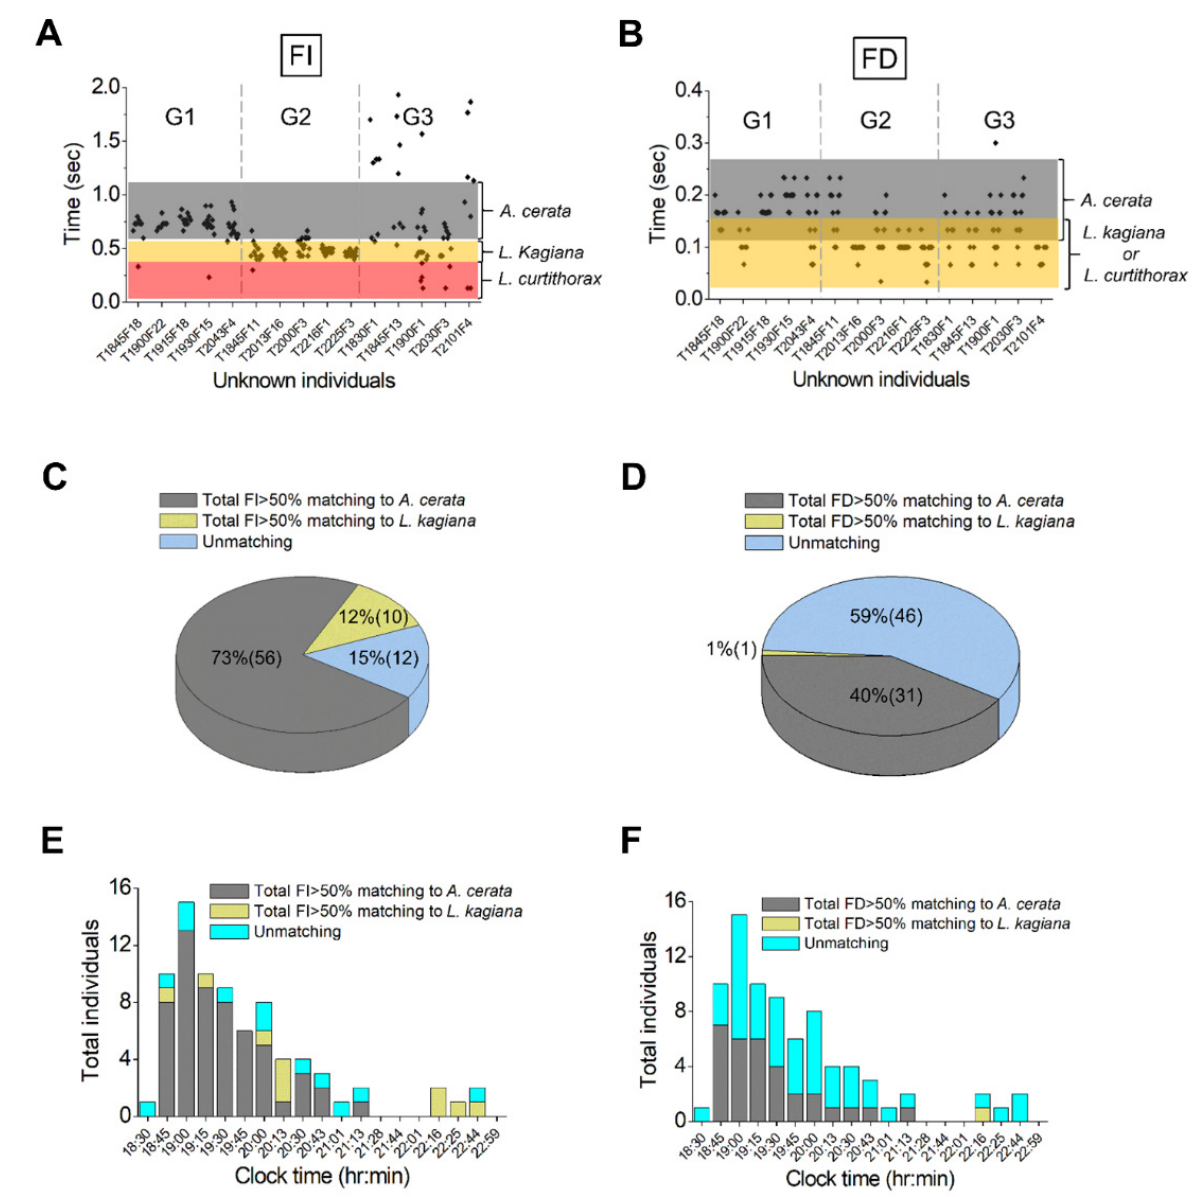
Figure 5. Determining the species composition and active time of the flying population in the case study using FI and FD pattern matching. For the case study on 21 April 2018, flying individuals can be divided into three distinct groups (G1, G2, and G3) according to their FI patterns. ( A ) FI and ( B ) FD patterns of 15 individuals from G1 to G3 are denoted. The FI or FD data points (black spots) of each studied individual (e.g., T1845F18) falling in the reference range of flying males of A. cerata (gray bar), L. kagiana (orange bar), or L. curtithorax (red bar) are shown. Each studied individual contributed 7–21 of the FI data points and 8–22 of the FD data points in this analysis. ( C , D ) The pie charts show the percentages and the total numbers (brackets) of A. cerata (gray), L. kagiana (orange), and unmatched individuals (blue) in the flying population, determined by FI and FD pattern matching. ( E , F ) Time-course bar charts display the nightly changes in individual numbers of the FI- or FD-identified A. cerata (gray), L. kagiana (orange), and unmatched individuals (blue). The details on the FI and FD pattern matching are described in Materials and